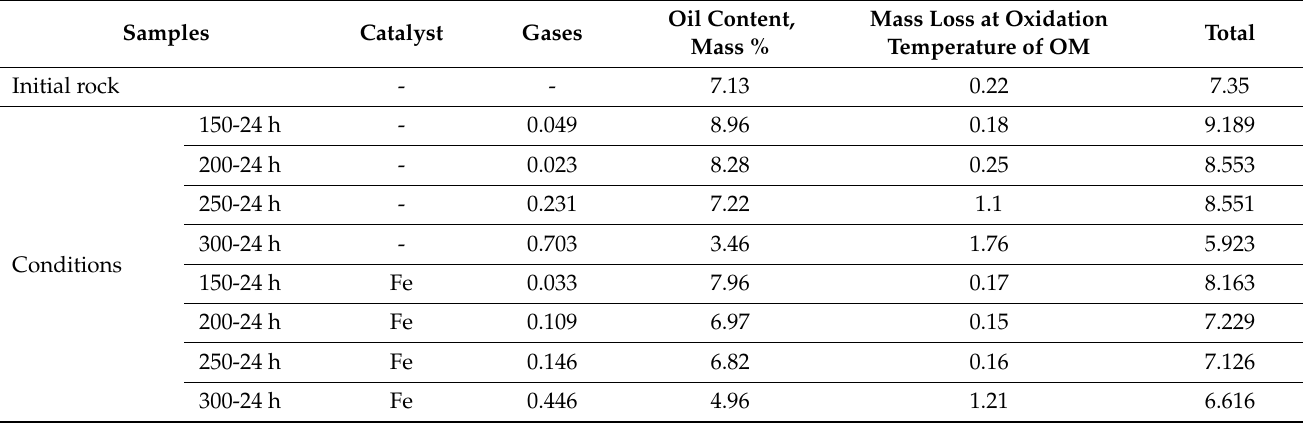
Table 2. Material balance for organic matter.